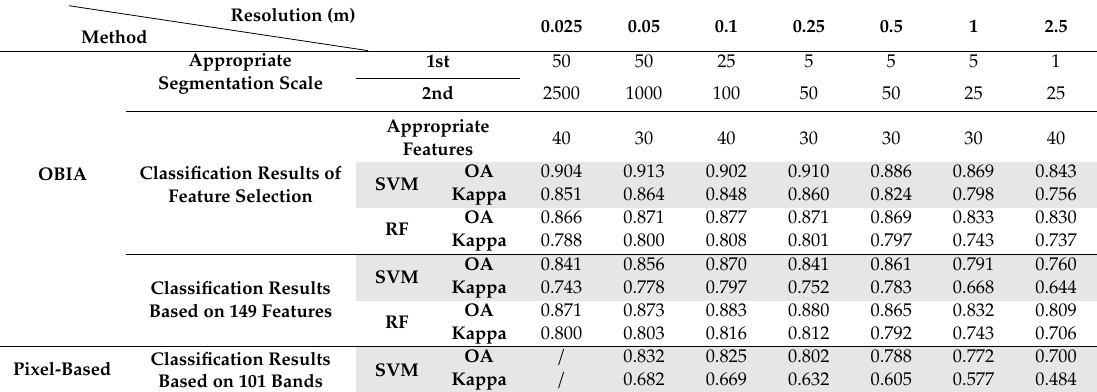
Table 6. Classification results of vegetation types for multi-scale images.